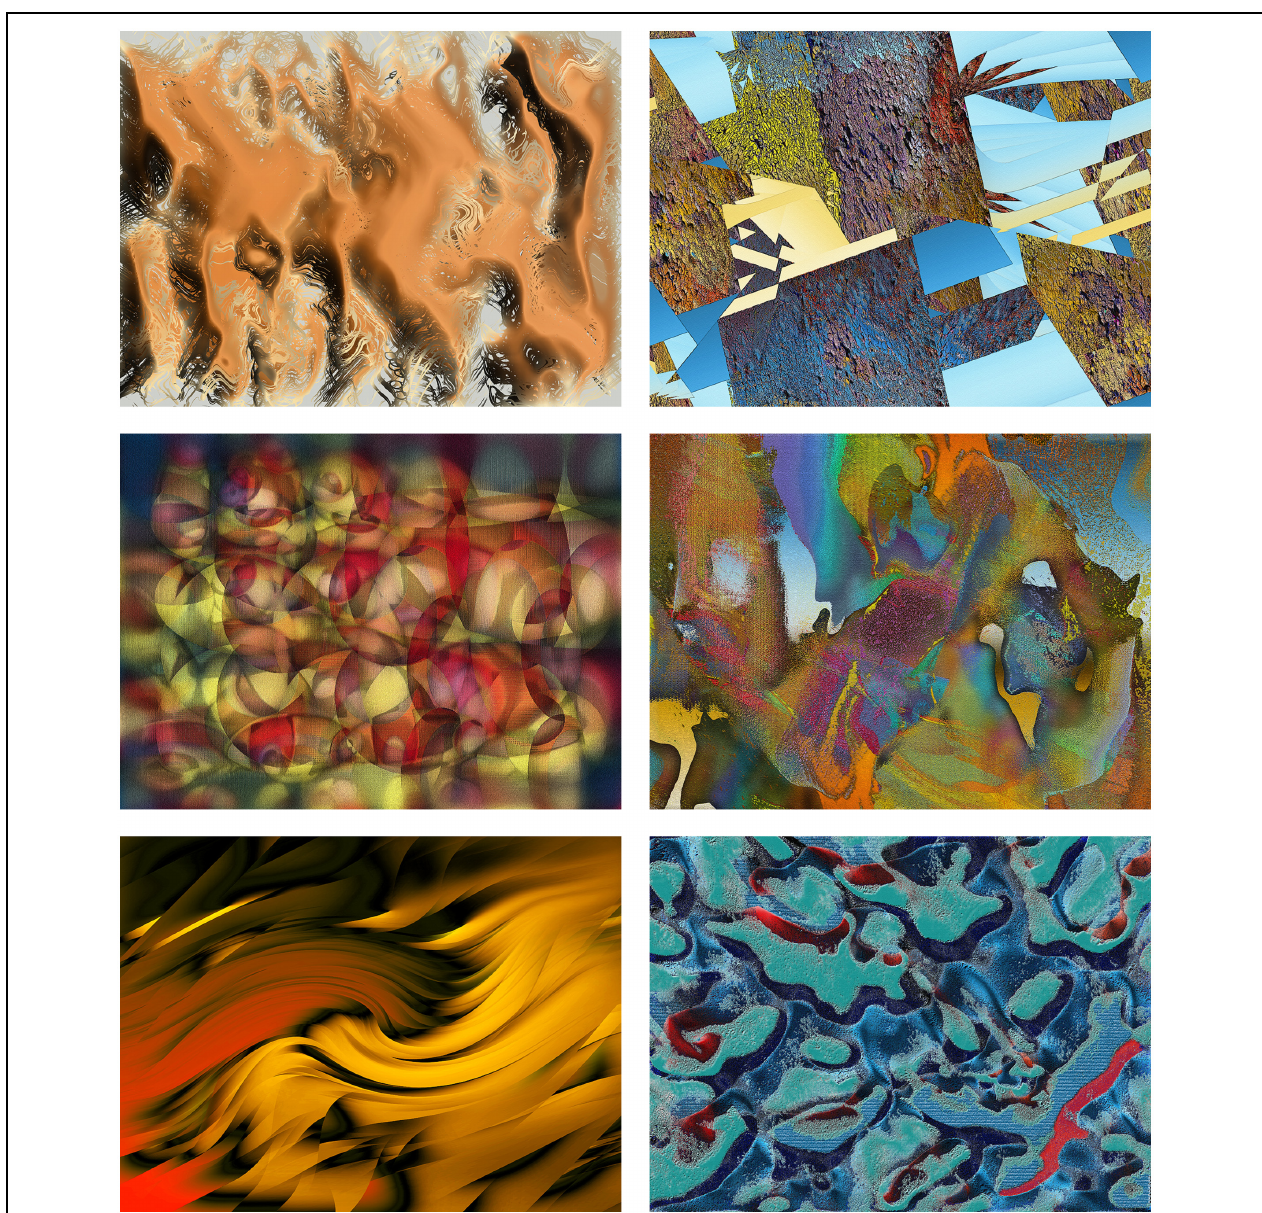
FIGURE 1 | Examples of stimuli used in the study. Images by © Reinhard